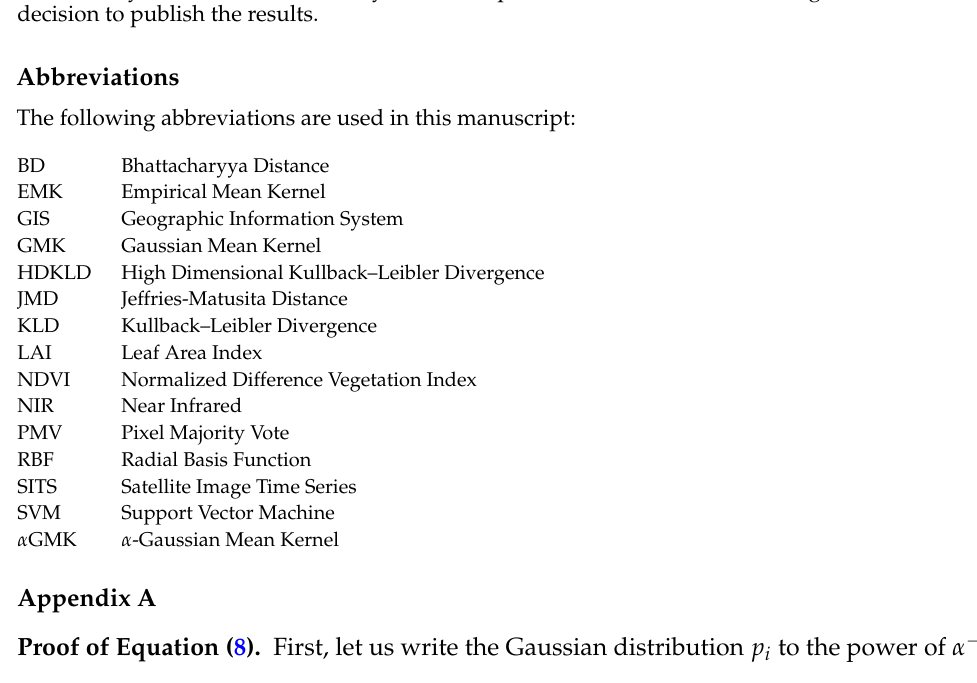
Figure S1: True color composite images of the Formosat-2 time series of 2014, Figure S2: Boxplot of Kappa coefficient repartitions for the classification of the old and young grasslands, Table S1: Average User Accuracy (UA) and Producer Accuracy (PA) (%) over the 100 repetitions for each class; 1: old, 2: young, Figure S3: Boxplot of Kappa coefficient repartitions for classification of management practices using time series of year (a) 2013 and (b) 2014, Table S2: Average UA and PA (%) over the 100 repetitions for each class; 1: mowing, 2: mixed, 3: